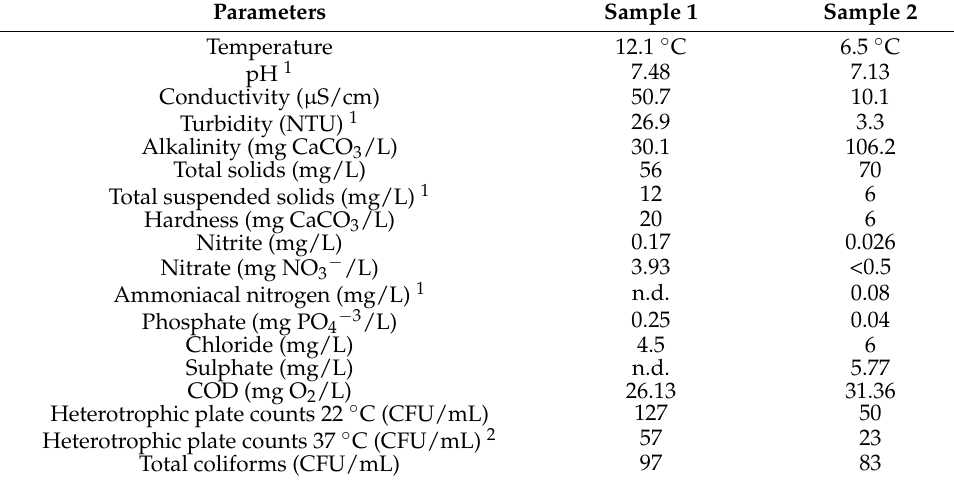
Table 7. Rainwater parameters recorded in March and April